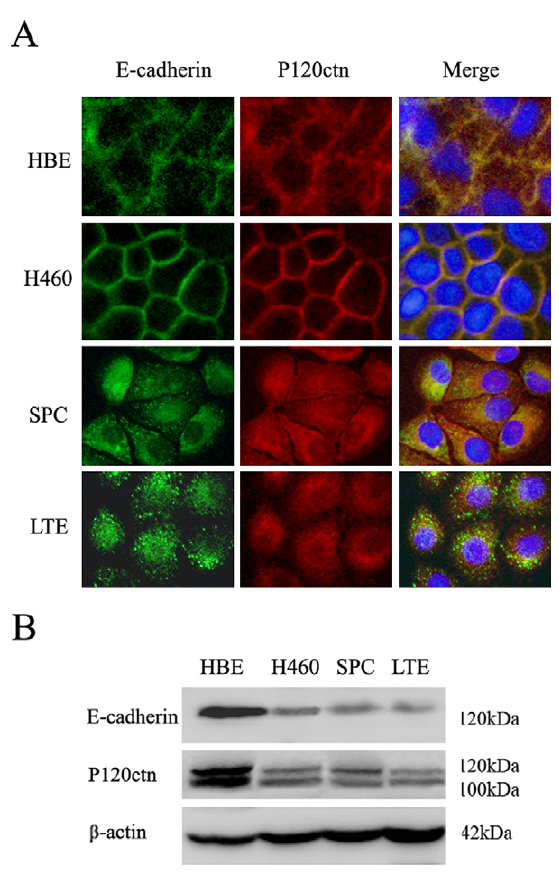
Figure 2. Expression and localization of p120ctn and E- cadherin. ( A ) By the immunofluorescence method, the expression of E-cadherin and p120ctn were noted to be restricted to the cell membrane at cell-cell adherens junctions in HBE and H460cells, whereas in SPC and LTE cells, E-cadherin and P120ctn were confined to the cytoplasm. ( B ) Western blot analyses confirmed E-cadherin and p120ctn were expressed in all four cell lines. Of all p120ctn isoforms, only two isoforms, p120ctn isoforms 1 (120 kDa) and 3 (100 kDa), were detected.